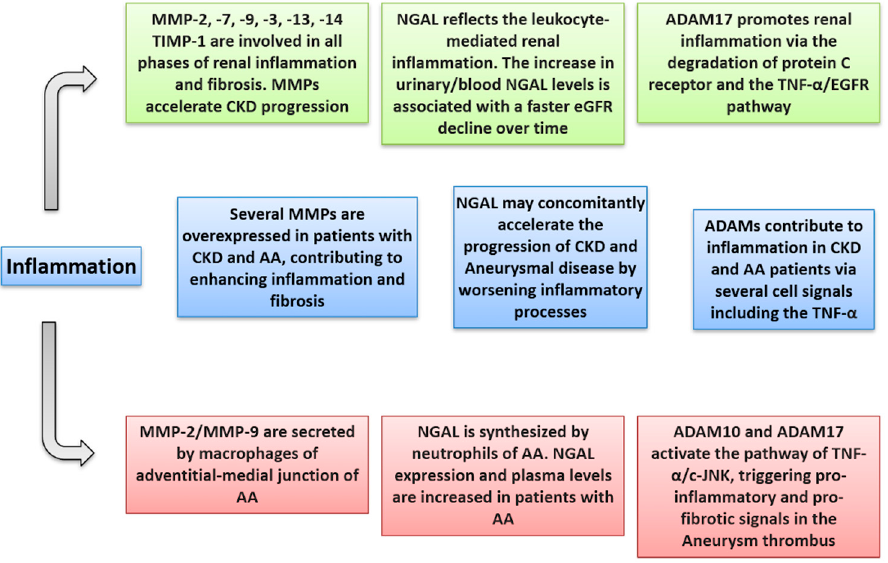
Figure 2. Inflammatory alterations that metalloproteinases may exert in CKD (green), aortic aneurysm (red), and both conditions (light blue).